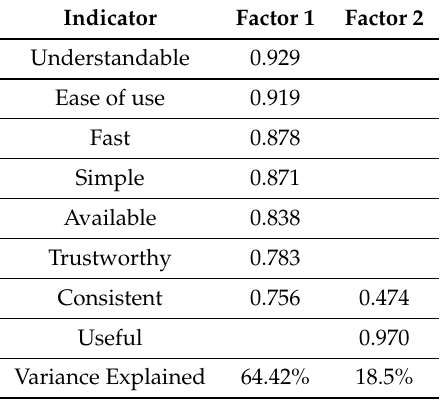
Table 7. Principal component